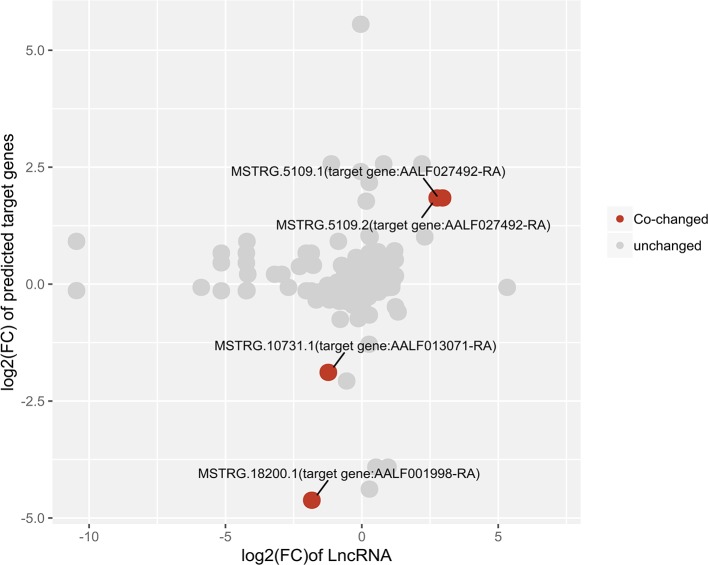
Correlation plot of lncRNA:mRNA pairs of differentially expressed lncRNAs and their predicted target protein-coding genes.